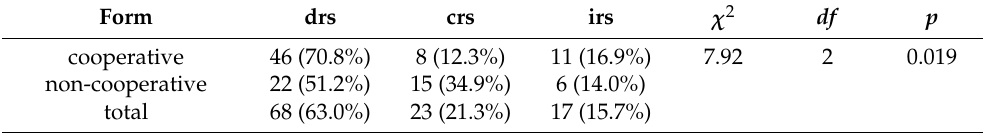
Table 9. Types of returns to scale by legal form of dairy (authors’ calculations based on [77]). Form drs crs irs χ 2 p cooperative non-cooperative